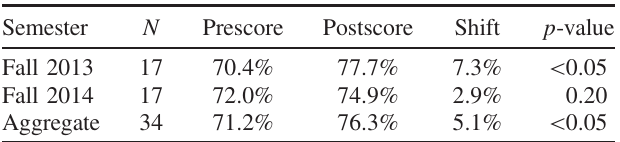
TABLE I. CLASS results from fall 2013 and fall 2014. Average presemester and postsemester percent favorable scores on the overall CLASS are listed. The shift in scores is also provided, as well as the significance of the shift ( p